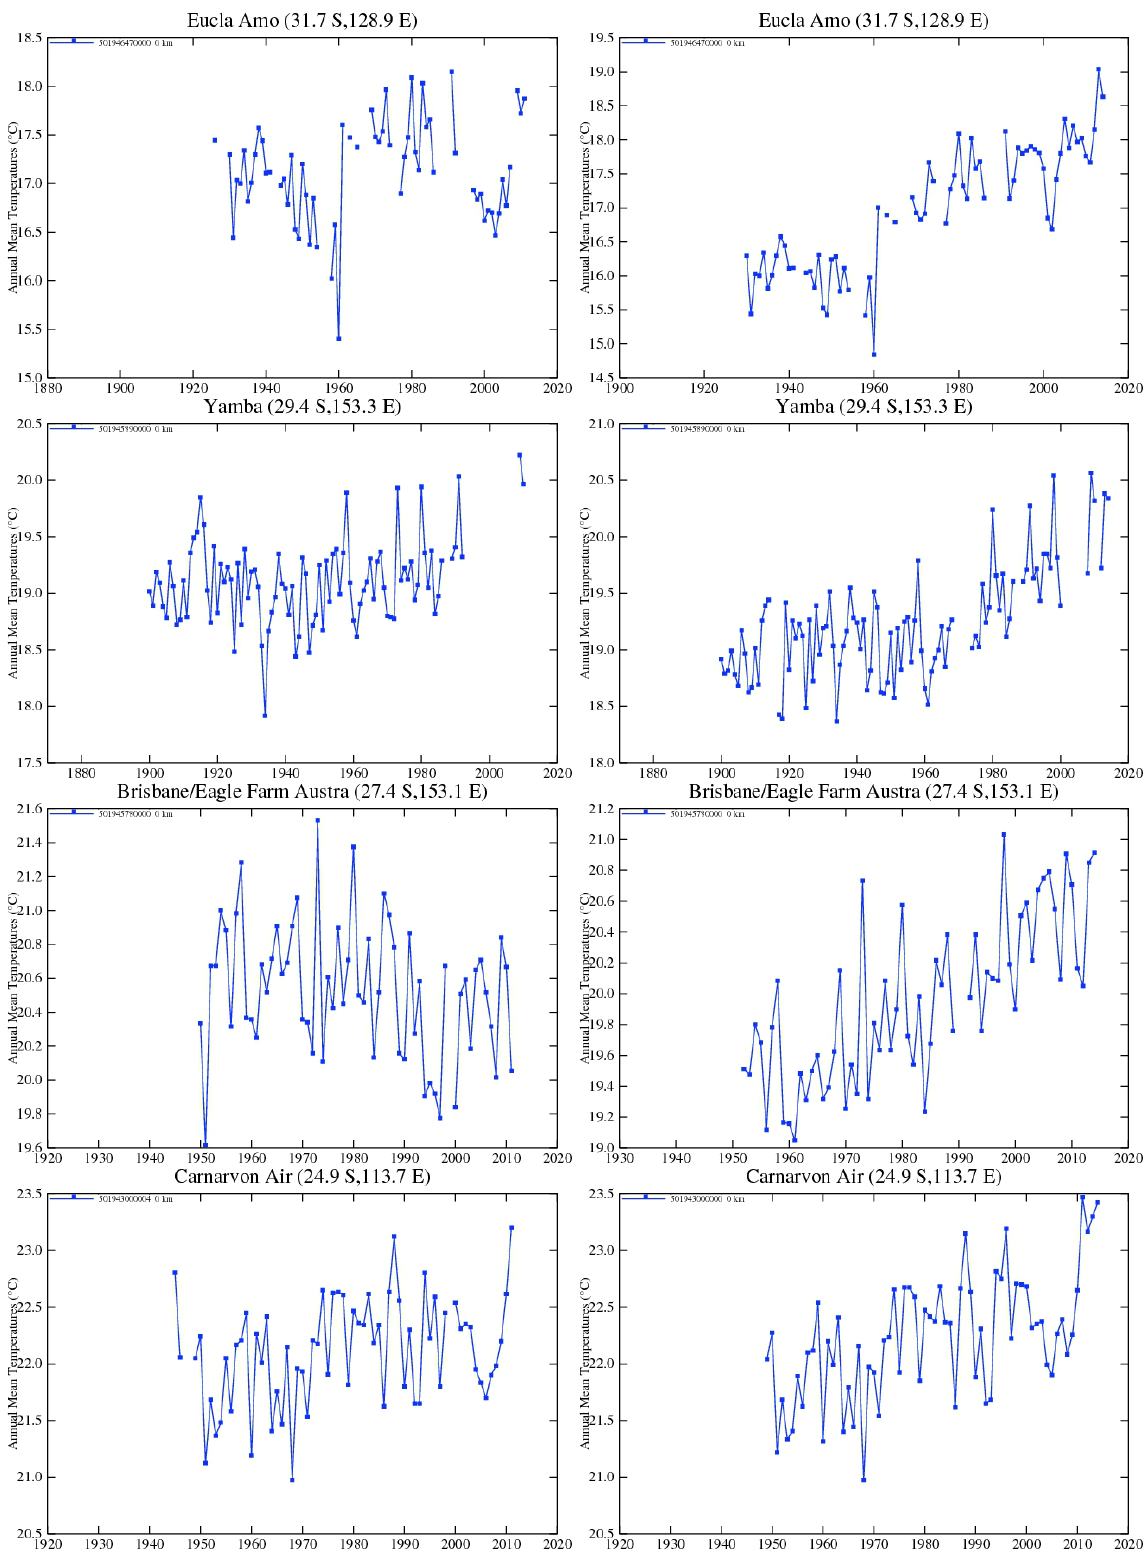
Fig. A.2: (Continued) GISS v2 vs. v3 temperature records for Darwin and Alice Springs, Northern Territory, Wilson Promontory, Cape Otway and Ballarat, Victoria, Adelaide Airport, South Australia, Eucla, Western Australia, Yamba, New South Wales, Brisbane/Eagle Farm, Queens- land, Carnarvon, Western Australia, Port Headland, Western Australia and Willis Island, an external territory of Australia. GISS v2 data on the left, GISS v3 data on the